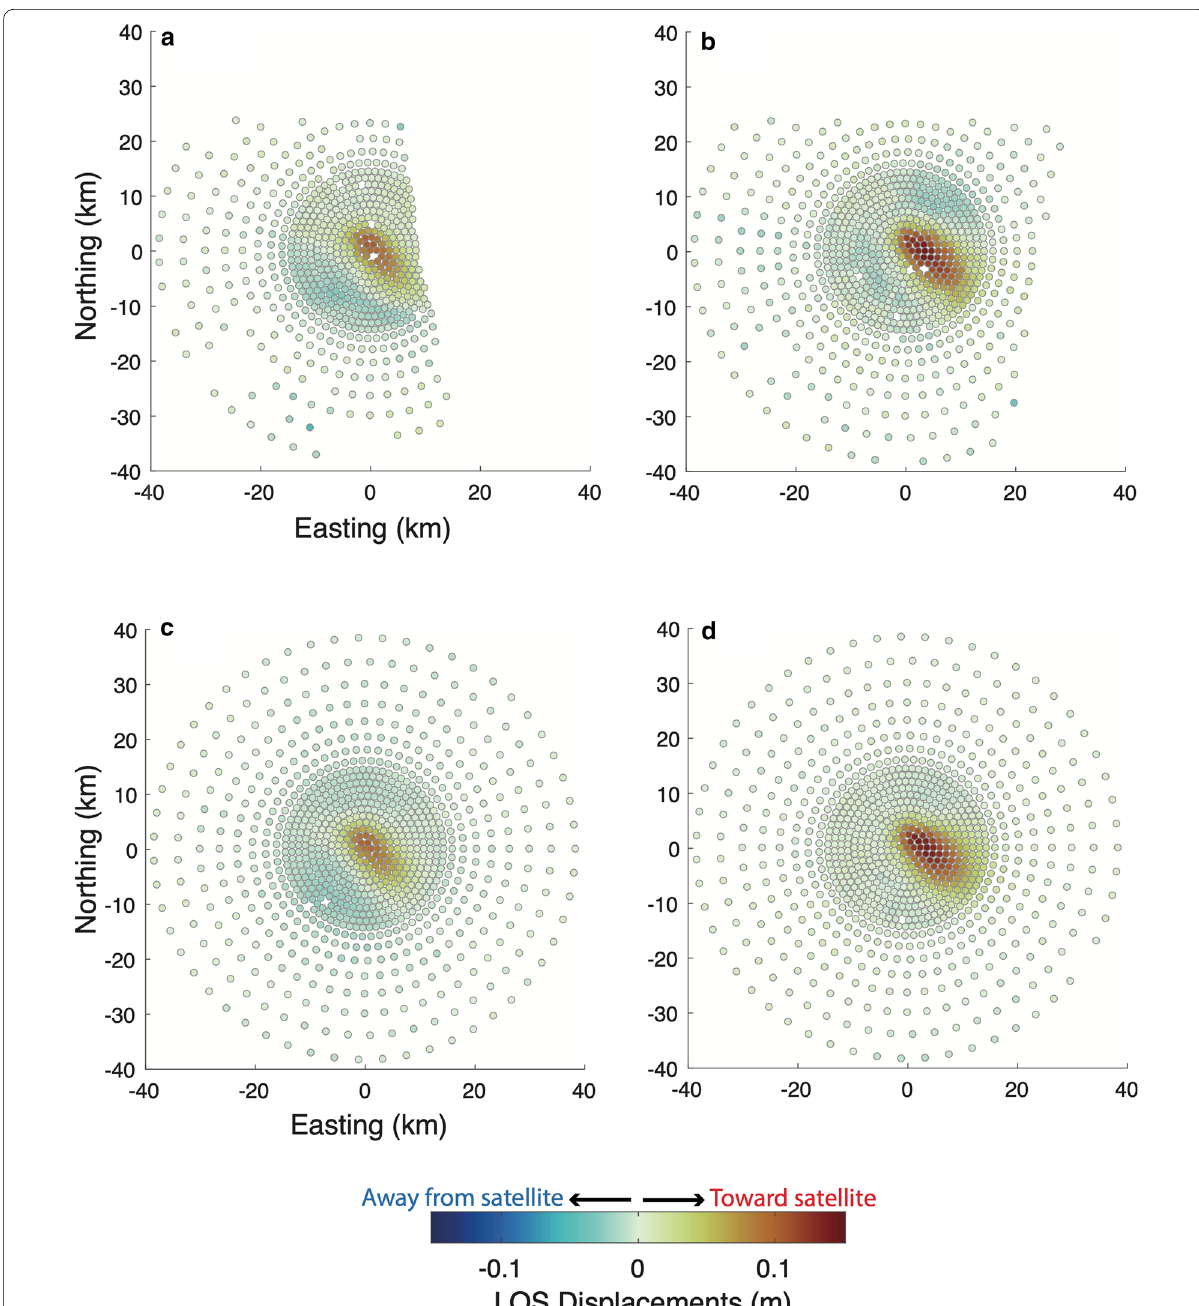
Fig. 4 Subsampled data points from the atmospheric corrected InSAR data that were used in the inversions, shown in kilometric Cartesian coordinates. a , b ALOS-2 ascending and descending subsampled data points, respectively. c , d Sentinel-1A ascending and descending subsampled data points,